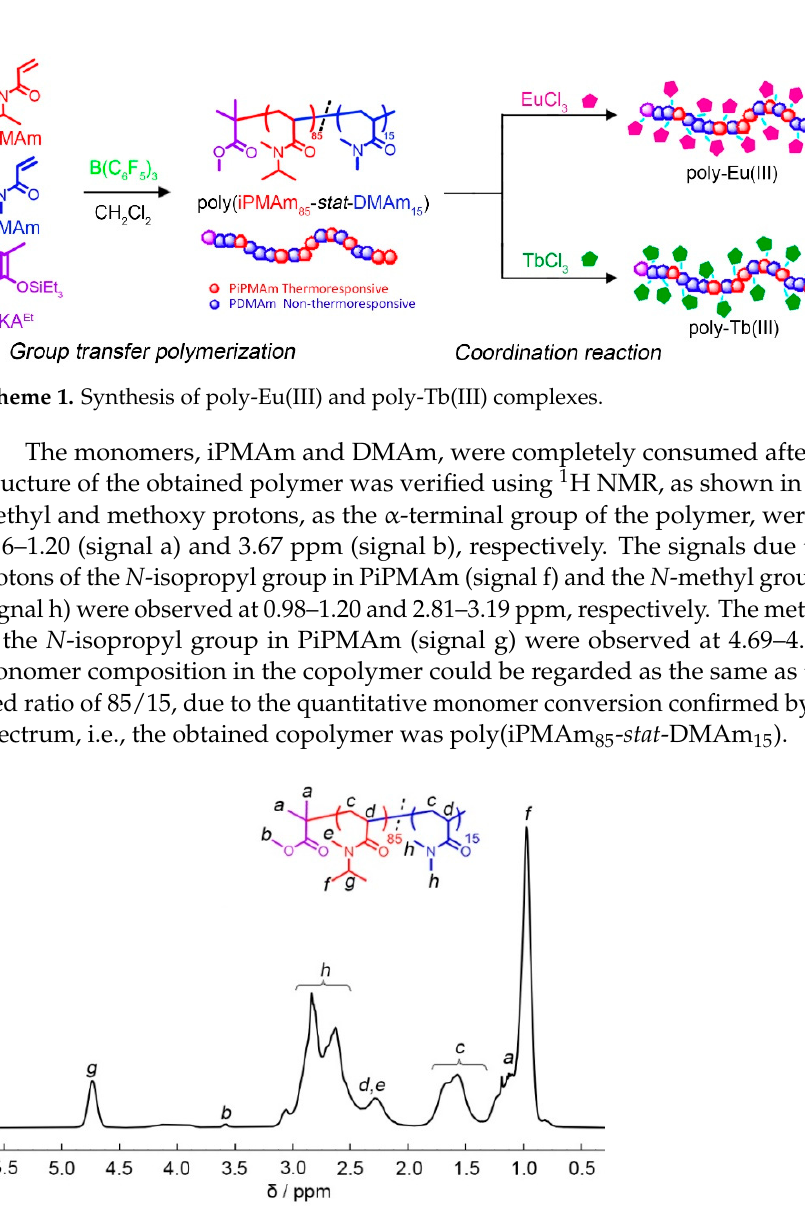
Figure 1. 1 H NMR spectra of PiPMAm 85 - stat -PDMAm 15 .